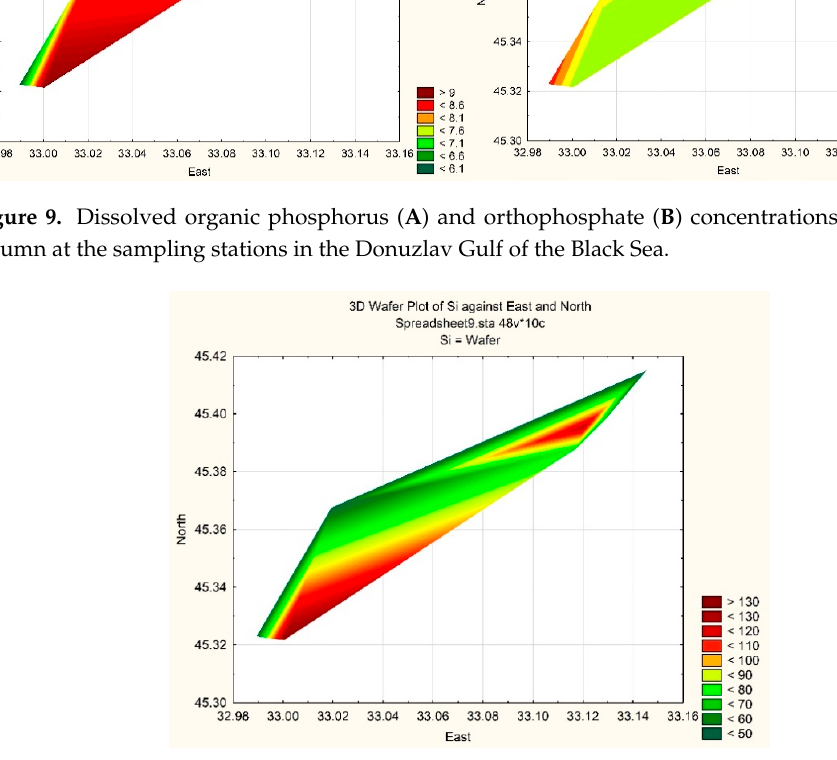
Figure 10. Concentrations of dissolved silicon in the water column at the sampling stations in the Donuzlav Gulf of the Black